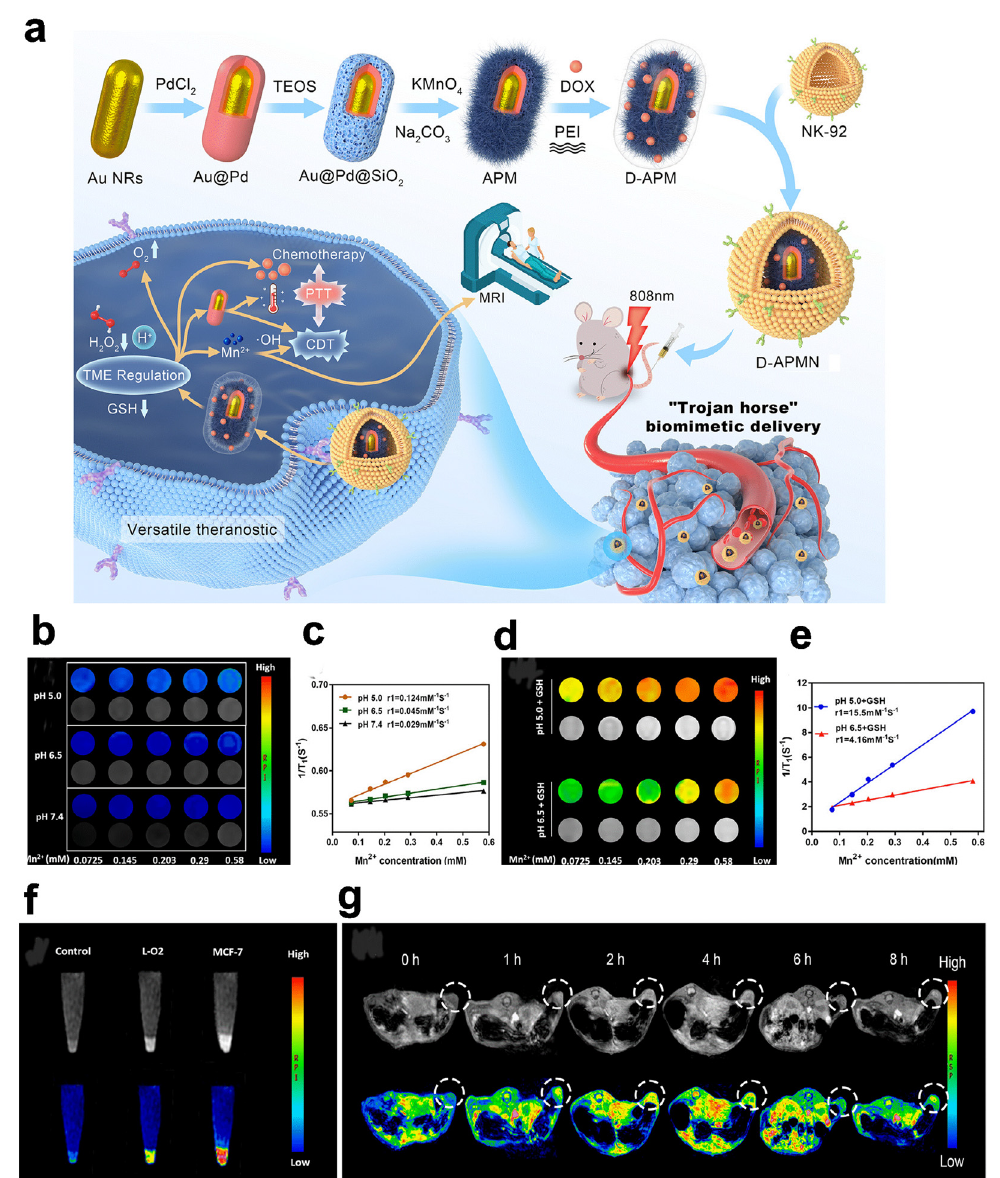
Figure 2. APMN NPs for MRI. ( a ) Schematic illustration of the main synthetic process of APMN NPs and the mechanism of this biomimetic theranostic nanoplatform for TME-responsive MR imaging and efficient induction of multimodal synergistic treatments. ( b – e ) MR images of APMN NPs under different conditions. ( f ) T 1 —weighted MR images of APMN NPs in cells. ( g ) T 1 —weighted MR images of MCF-7 tumor-bearing nude mice. Reproduced with permission from Ref. [100].